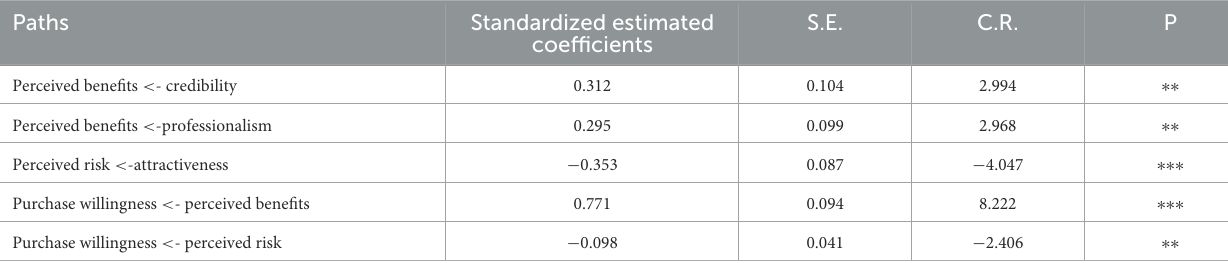
TABLE 5 Standardized path coefficients and hypothesis testing